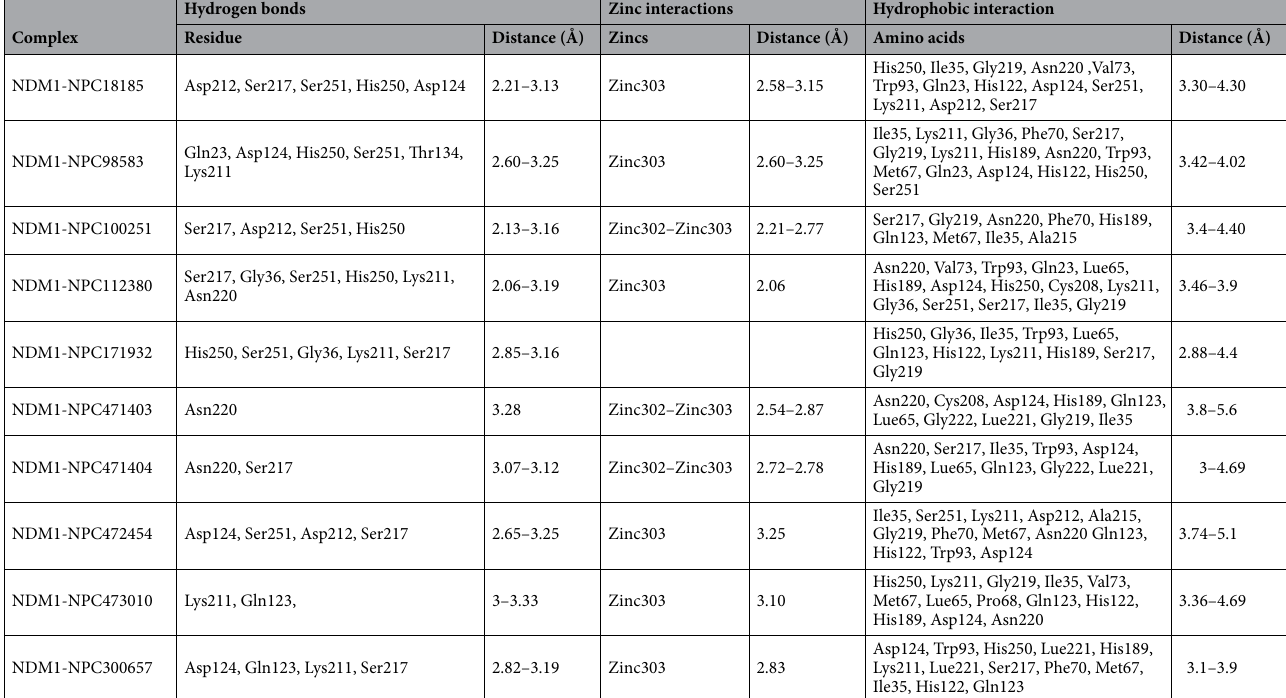
Table 2. Hydrogen bonding and hydrophobic interactions of the complexes and distance between atoms ligands and